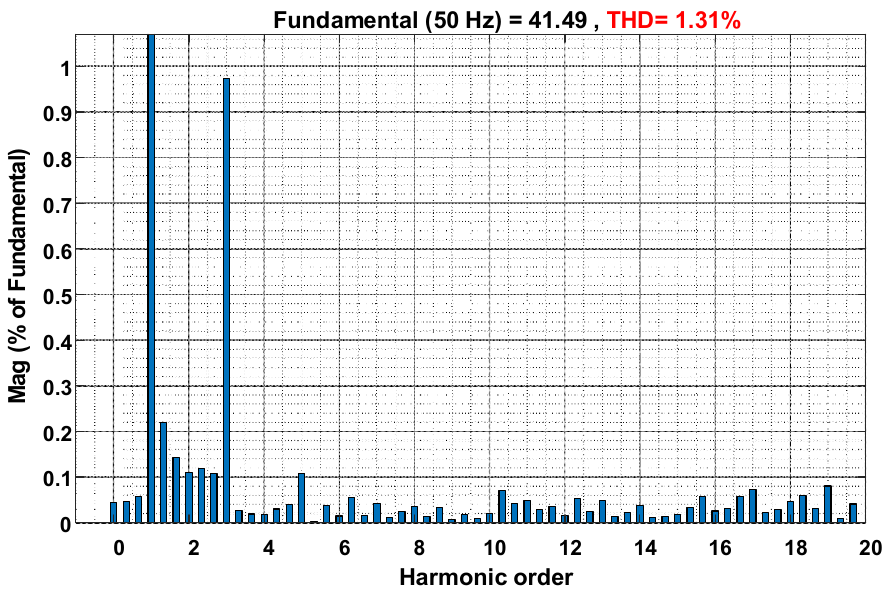
Figure 10. HVAC grid current THDi (50% of rated power). Figure 11 shows the simulation results of grid current, HVDC DC bus voltage, LVDC DC bus voltage, and LVDC DC current under the condition of battery power step from 50% to 80%. It can be seen that the dynamic response process of the HVAC AC side is less than 20 ms with no overshoot. The peak value of transient overvoltage at the LVDC side is about 744 V and overshoot is about 0.01%, and the peak value of transient overcurrent at the LVDC side is about 1190 A and overshoot is about 0.09%, which is within the allowable range. Under the condition of 50% rated power, the output current THDi is 1.76%, as shown in Figure